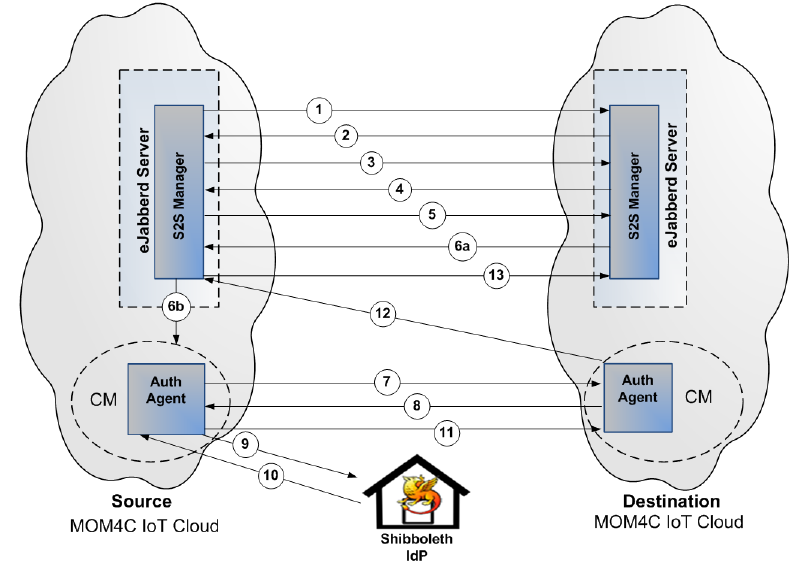
Figure 8. Step performed by two XMPP servers aiming to build an IoT Cloud federation: the authentication process is executed using SAML 2.0 as external SASL